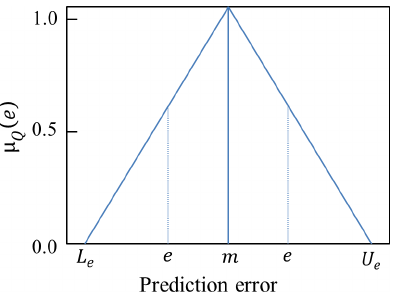
Figure 1. A triangular membership function for converting the streamflow prediction error into a normalized